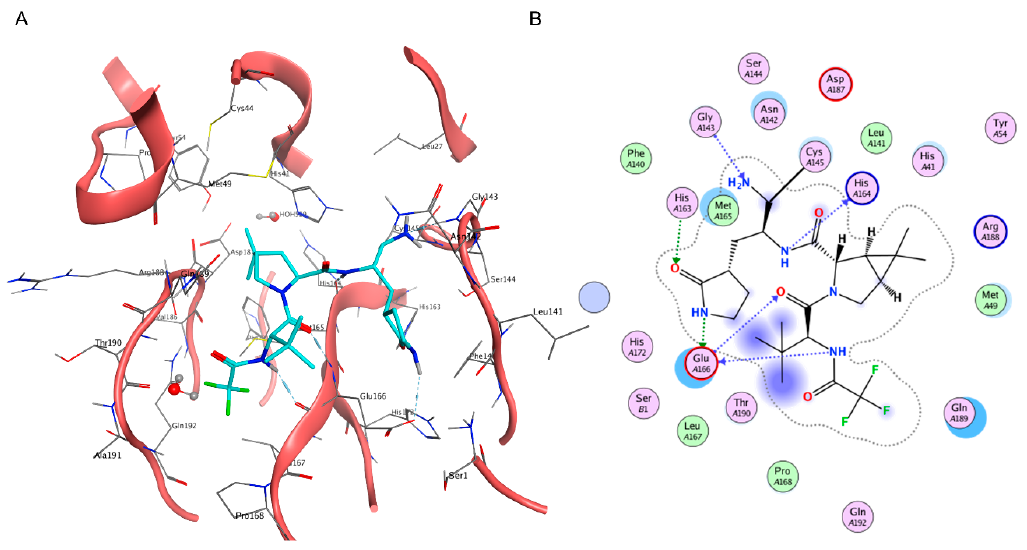
Figure 3. ( A ) Three-dimensional depiction of Nirmatrelvir orientation within the catalytic site of SARS-CoV-2 M pro (PDB ID: 7RFW). ( B ) Bidimensional representation of intermolecular interactions of Nirmatrelvir–SARS-CoV-2 M pro 7RFW complex.